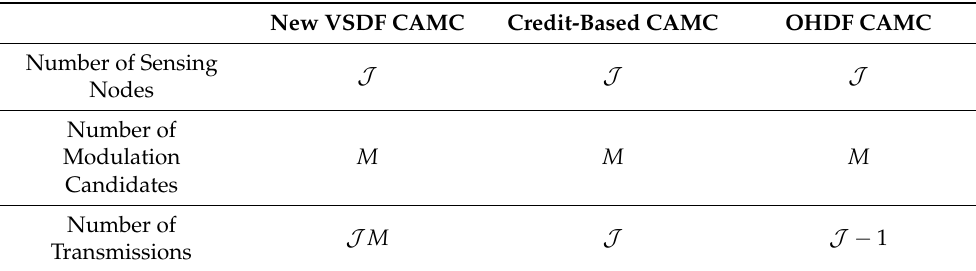
Table 2. The numbers of required transmissions of our proposed VSDF CAMC approach, the existing credit-based CAMC Method in [23], and the existing OHDFCAMC method in [19] during one sensing